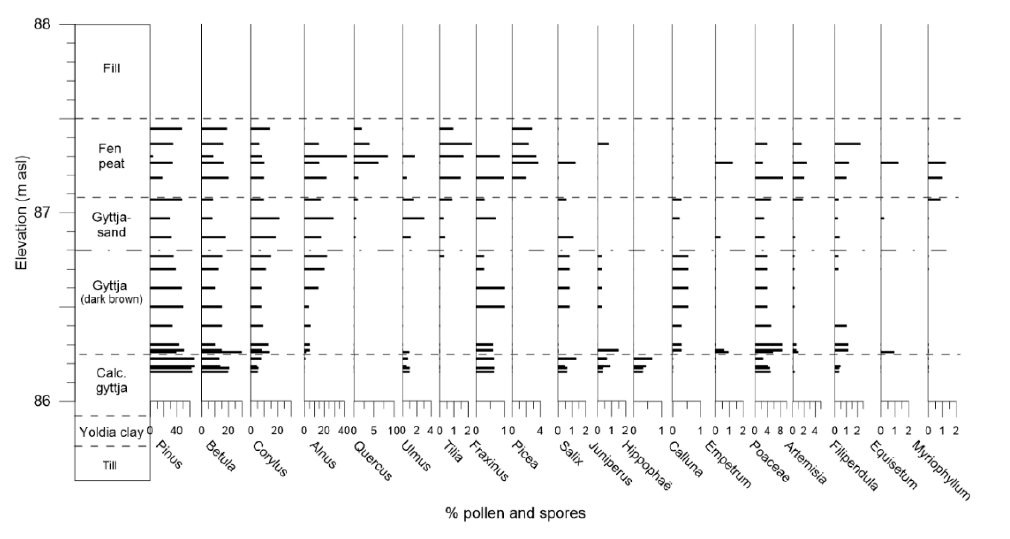
Figure 6. Pollen percentage data from section C 13059.